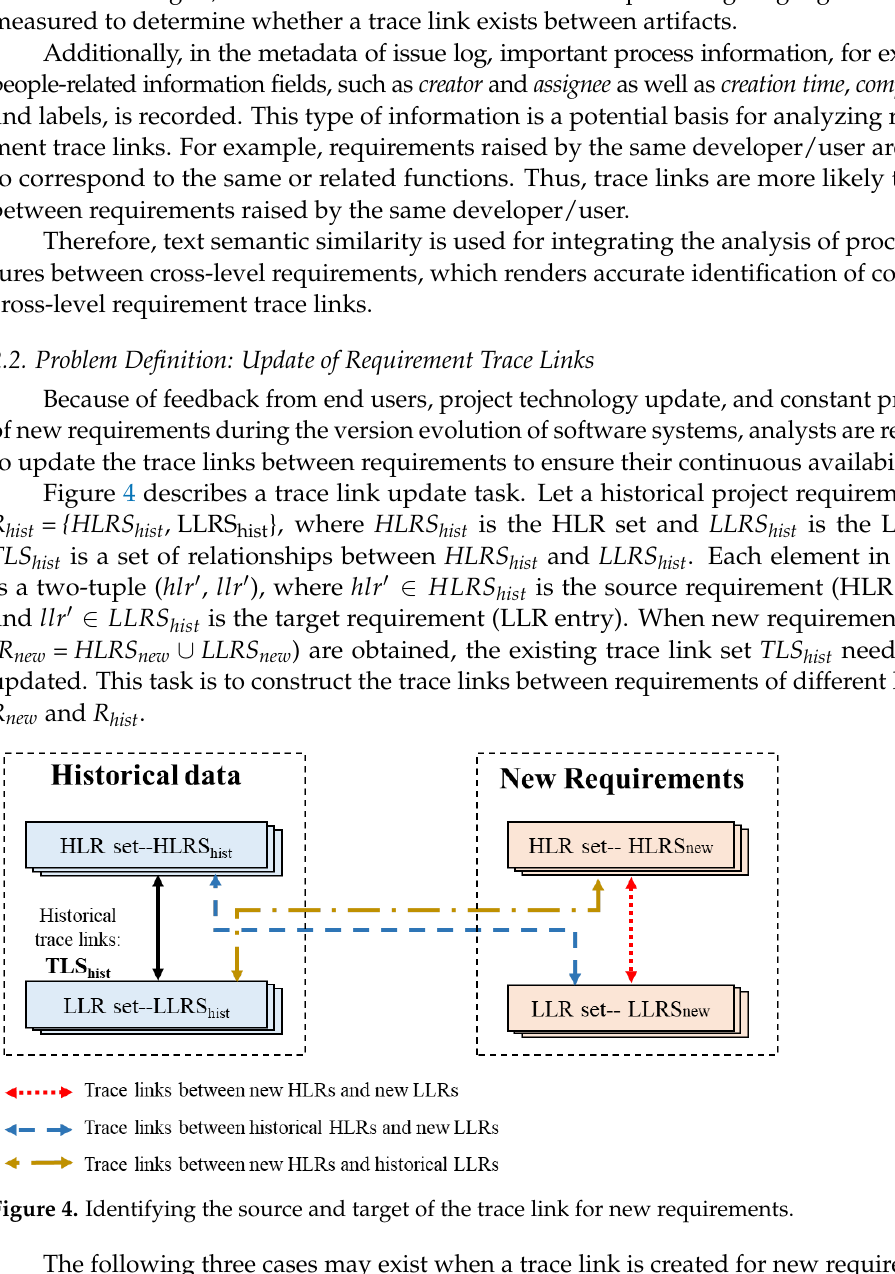
5 of 26 Figure 3. Requirements of different abstraction levels in JIRA and their decomposition relation- ships. Cross-level requirement traceability means trace links between requirements in dif- ferent abstraction levels. Given that traceability is primarily used to record the decompo- sition relationship between requirements, we focus on the trace links between the require- ments of adjacent levels, i.e., parent – standard and standard – child in JIRA. In an open-source system, the raw data of requirement issue logs contain rich textual information and process information [30]. The textual information of the issue log is con- tained in two fields: summary (a concise summary of the issue) and description (a detailed description of the issue) [31]. When manually constructing a requirement trace link, an analyst should read and understand the text descriptions such as summary and description